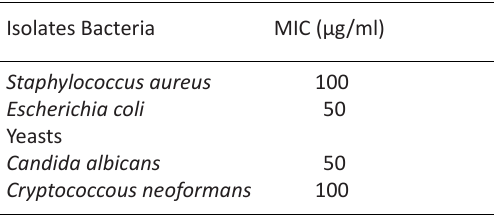
Table 6. Antibacterial and antifungal activity of Myristica fragrans alkaloid extract against some bacterial and yeast isolates